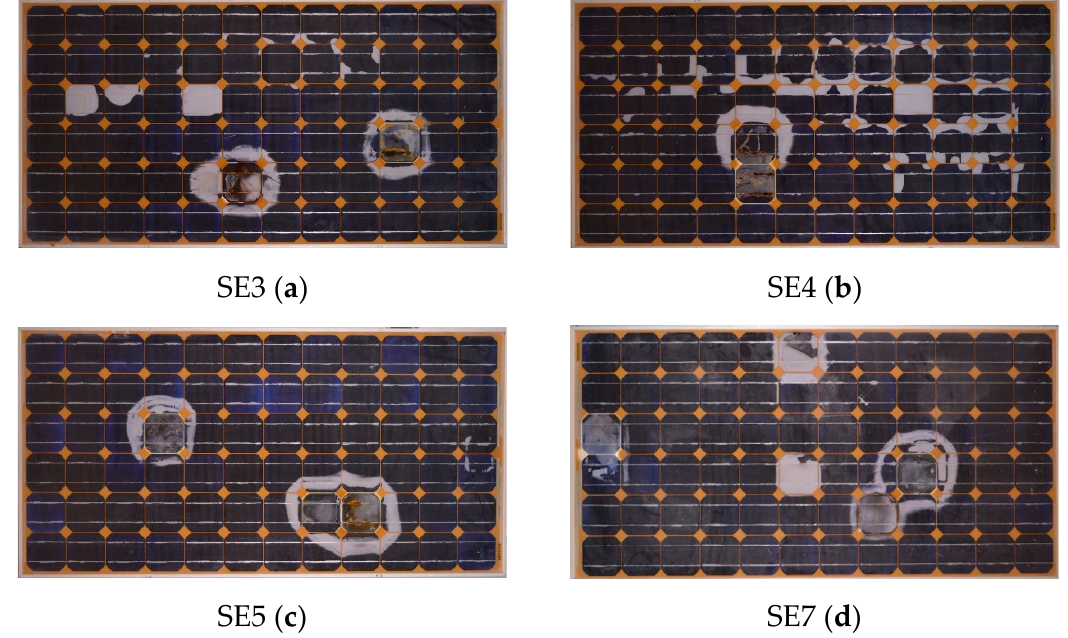
Figure 7. Red, green, blue (RGB) images of the 175W Eoplly mono-crystalline defective modules analyzed in the research: ( a ) module 1; ( b ) module 2; ( c ) module 3; ( d ) module 4.